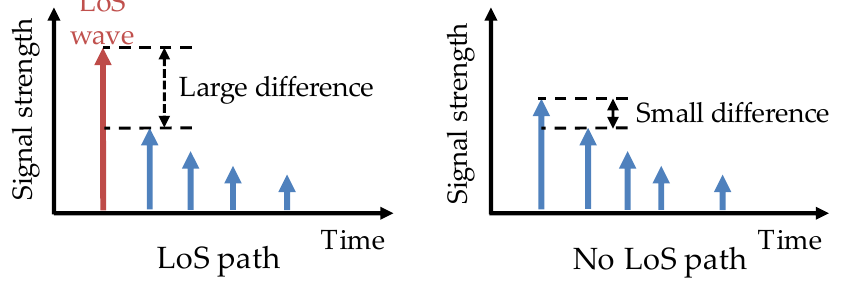
Figure 3. Presence detection of the LoS (line of sight) wave. The difference between the signal strengths of the first wave and the second one is large when there is a LoS path, and small otherwise.